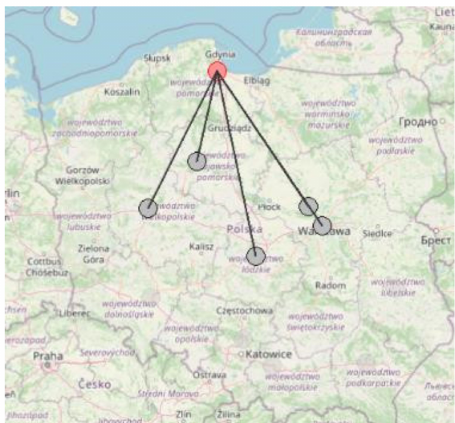
Figure 5. Connectivity map-graph for the outlier airport EPGD. Note: only EPGD is marked pink as a high-low outlier; at a significant level with p -value = 0.05. Other airports are marked as non- significant outliers. Source: own elaboration based on data from Tables 1 and 4. Basemap from © OpenStreetMap contributors 2021 [44]. Distributed under a CC BY-SA